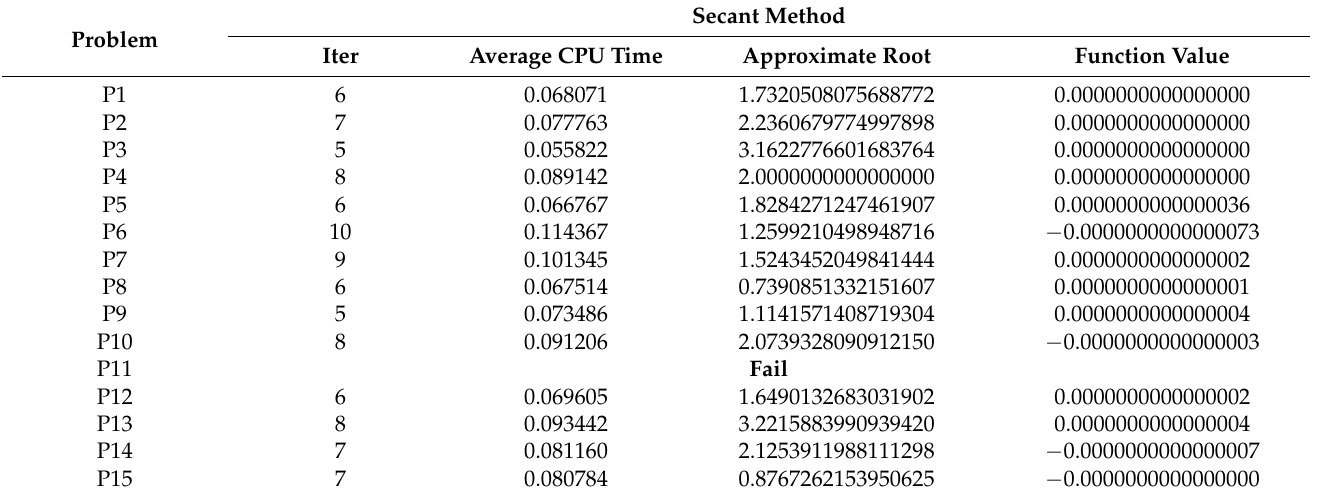
Table 7. Solutions of fifteen problems by the secant method.